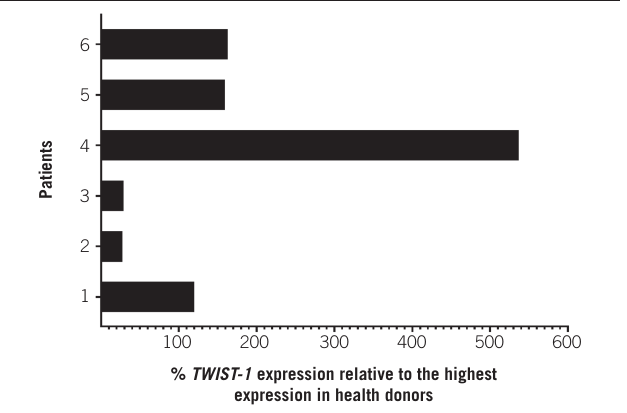
FIGURE 2 – Overexpression of TWIST-1 gene in six of the breast cancer patients studied. The graph shows percentage of increase in the expression over the estimated maximum value of the expression in healthy donors